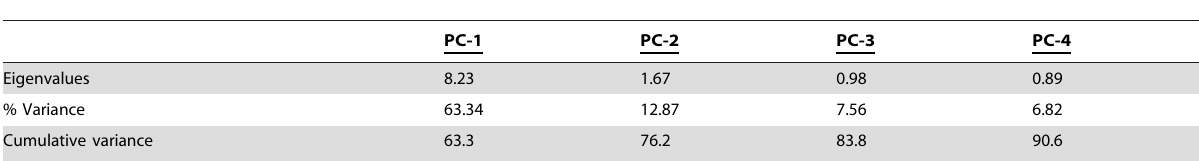
Table 4. Results of principal component analyses (PCA).